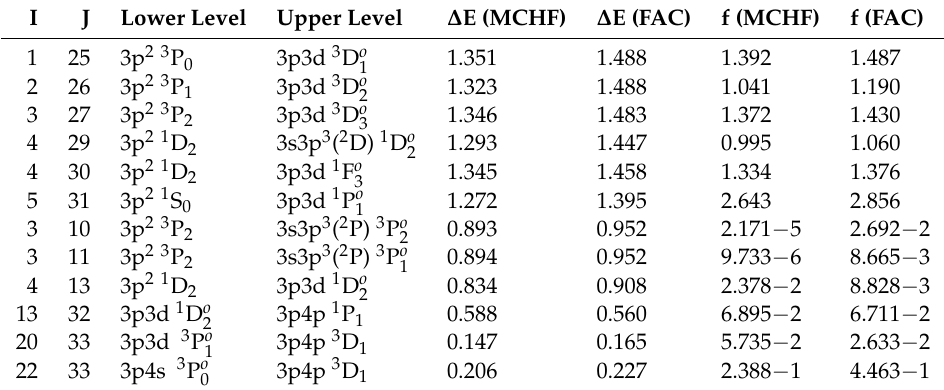
Table 1. Comparison of energies ( ∆ E, Ryd) and oscillator strengths (f-values, dimensionless) for some transitions of S III. a ± b ≡ a × 10 ± b . MCHF, multi-configuration Hartree–Fock; FAC, flexible atomic code.